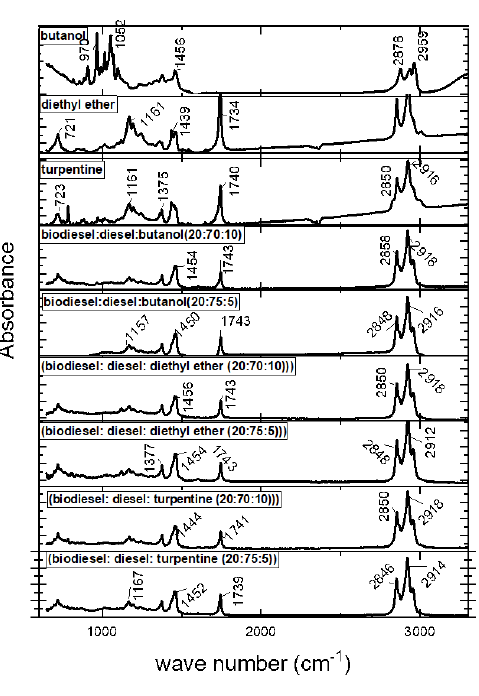
Fig. 6. ATR-FTIR absorption spectra of biodiesel, diesel, turpentine, diethyl ether and butanol blends in the range of 600 cm − 1 -3500 cm −